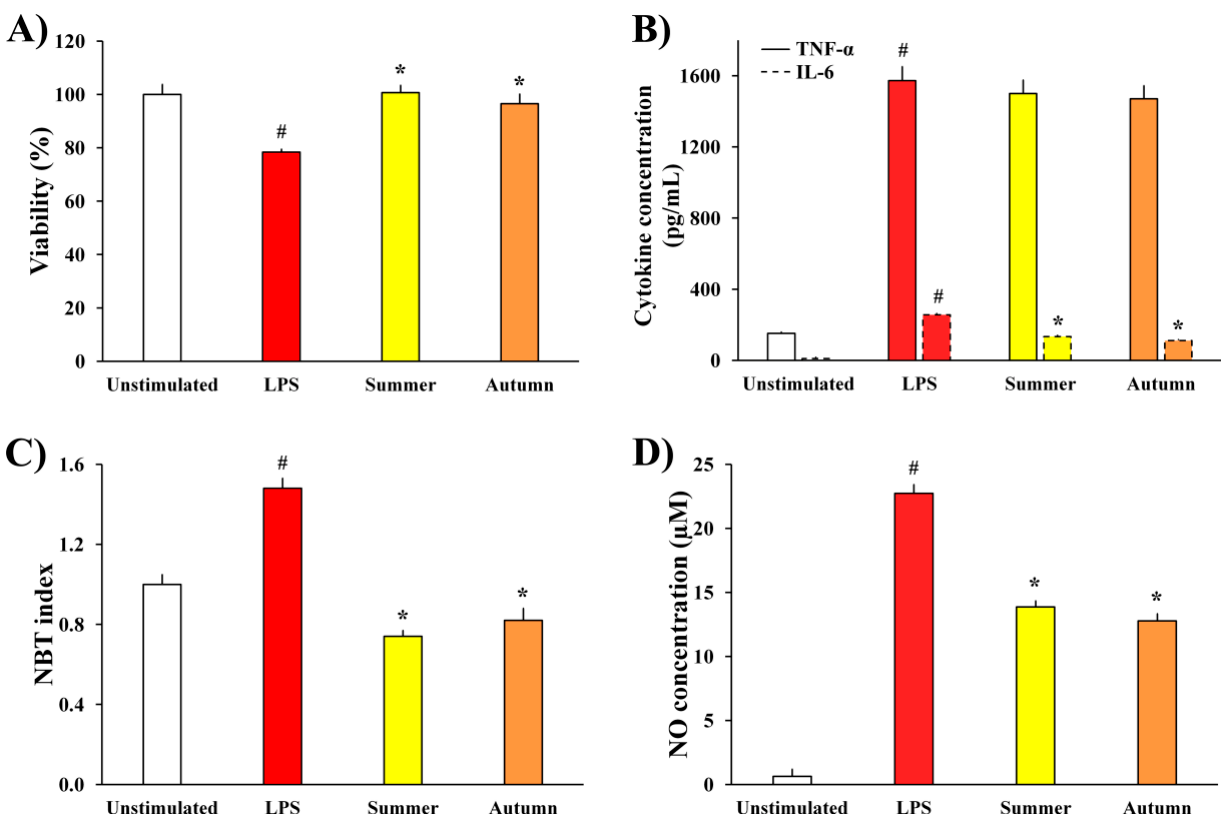
Figure 3. The effects of H. cupressiforme ethyl acetate extracts from different seasonal aspects (summer and autumn) on ( A ) metabolic activity, ( B ) cytokine production, ( C ) ROS production, and ( D ) NO production by LPS-stimulated BV2 microglial cells. The results are presented as the mean ± standard error (# p < 0.05 unstimulated cells vs. LPS-stimulated; * p < 0.05 LPS-stimulated vs. moss-treated and LPS-stimulated cells).